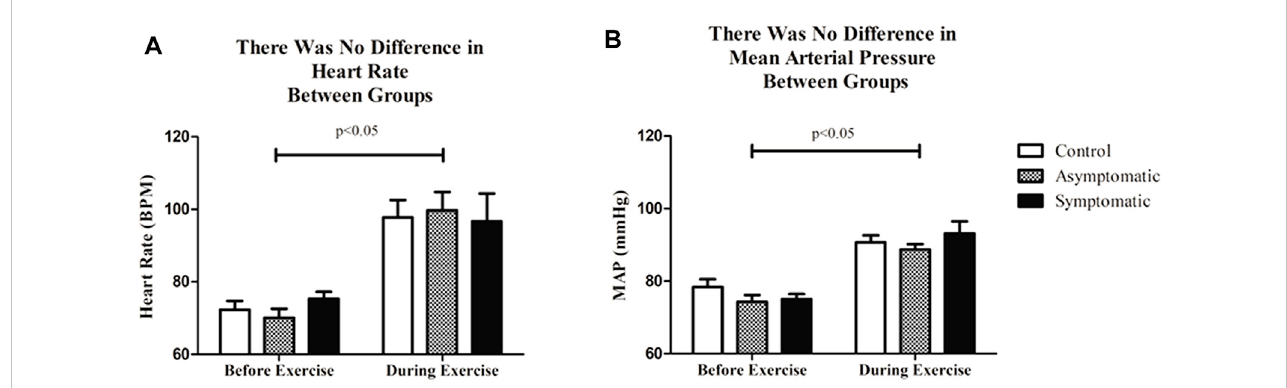
FIGURE 2 (A) Therewasnodifferenceinaverageheartrateor (B) MAPbeforeorduringsubmaximaltreadmillexercisebetweengroups. n =9/group;Dataanalyzed by a Two-Way Repeated Measures ANOVA with a Bonferroni post-hoc. Data are presented as mean ± SE; HR = heart rate; MAP = mean arterial pressure. Signi fi cance was set to p <